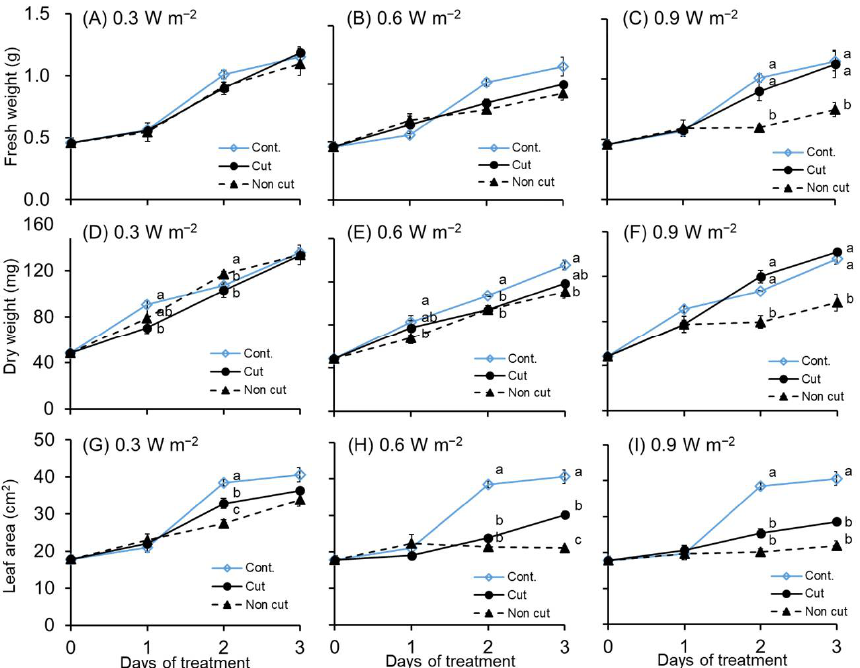
Figure 2. Effects of UV irradiation with or without 300 nm short-cut filters on fresh weight ( A – C ), dry weight ( D – F ), and leaf area ( G – I ) of the third leaf for 0–3 days of treatment. ( A , D , G ) indicated 0.3 W m −2 ; ( B , E , H ) indicated 0.6 W m −2 ; ( C , F , I ) indicated 0.9 W m −2 . The UV irradiation intensity was set at 0.3, 0.6, and 0.9 W m −2 . The vertical bars indicate SE ( n = 3–6). Different letters indicate signif- icant differences among the treatments at p < 0.05 by Tukey–Kramer’s test.